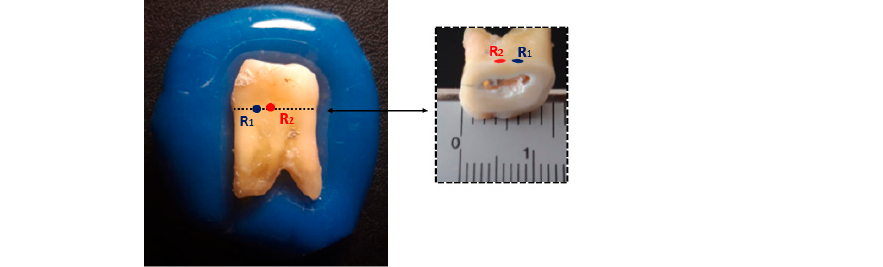
Figure 7. Illustration of the measurement locations on the molar root: R1—smooth and flat surface; R2—concave surface. At the measuring sites, the thickness of the root wall was approximately 2 mm. The pulp cavity had a thickness of approximately 2 mm and was partially filled with devitalized tissue.